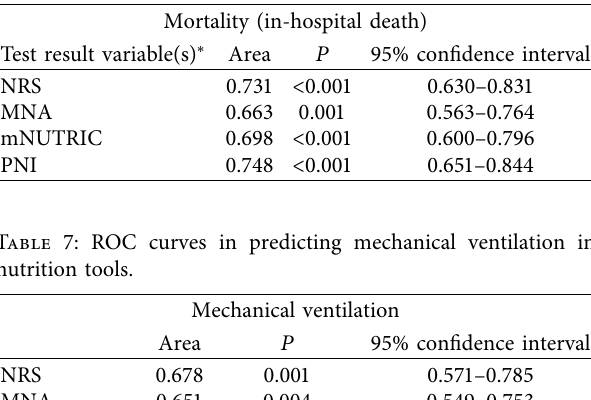
Table 6: ROC curves in predicting mortality in nutrition tools.